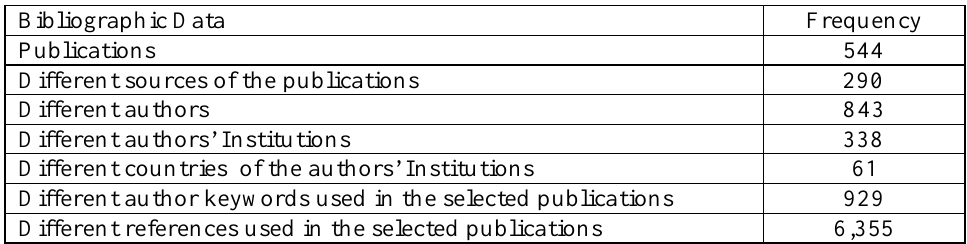
General Bibliographic Data of the Selected Publications